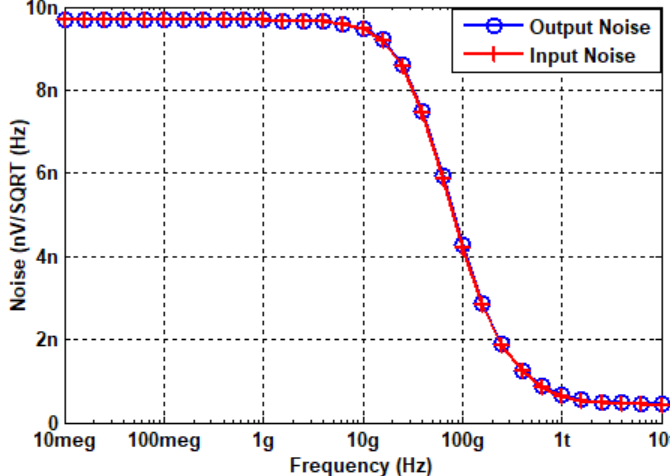
Figure 12. Frequency-response of input and output noise of AOTAPF at V tune = − 0.32